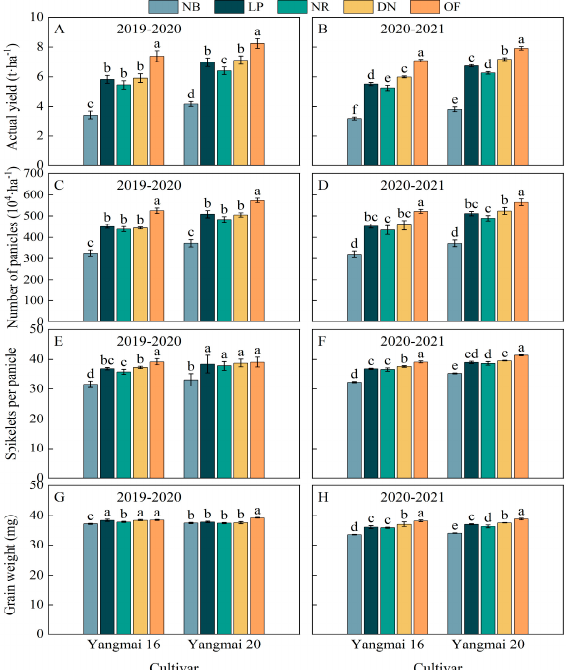
Figure 6. Effects of integrated cultivation practices on yield ( A , B ) and its components ( C – H ) of wheat. NB, LP, NR, DN, and OF indicate nitrogen blank area, local practices, nitrogen reduction, planting density reduction and nitrogen reduction, and organic fertilizer, respectively. Vertical bar represents the ±standard error of the mean. Different lowercase letters indicate the same period; the difference between different treatments was significant at the 0.05 level.